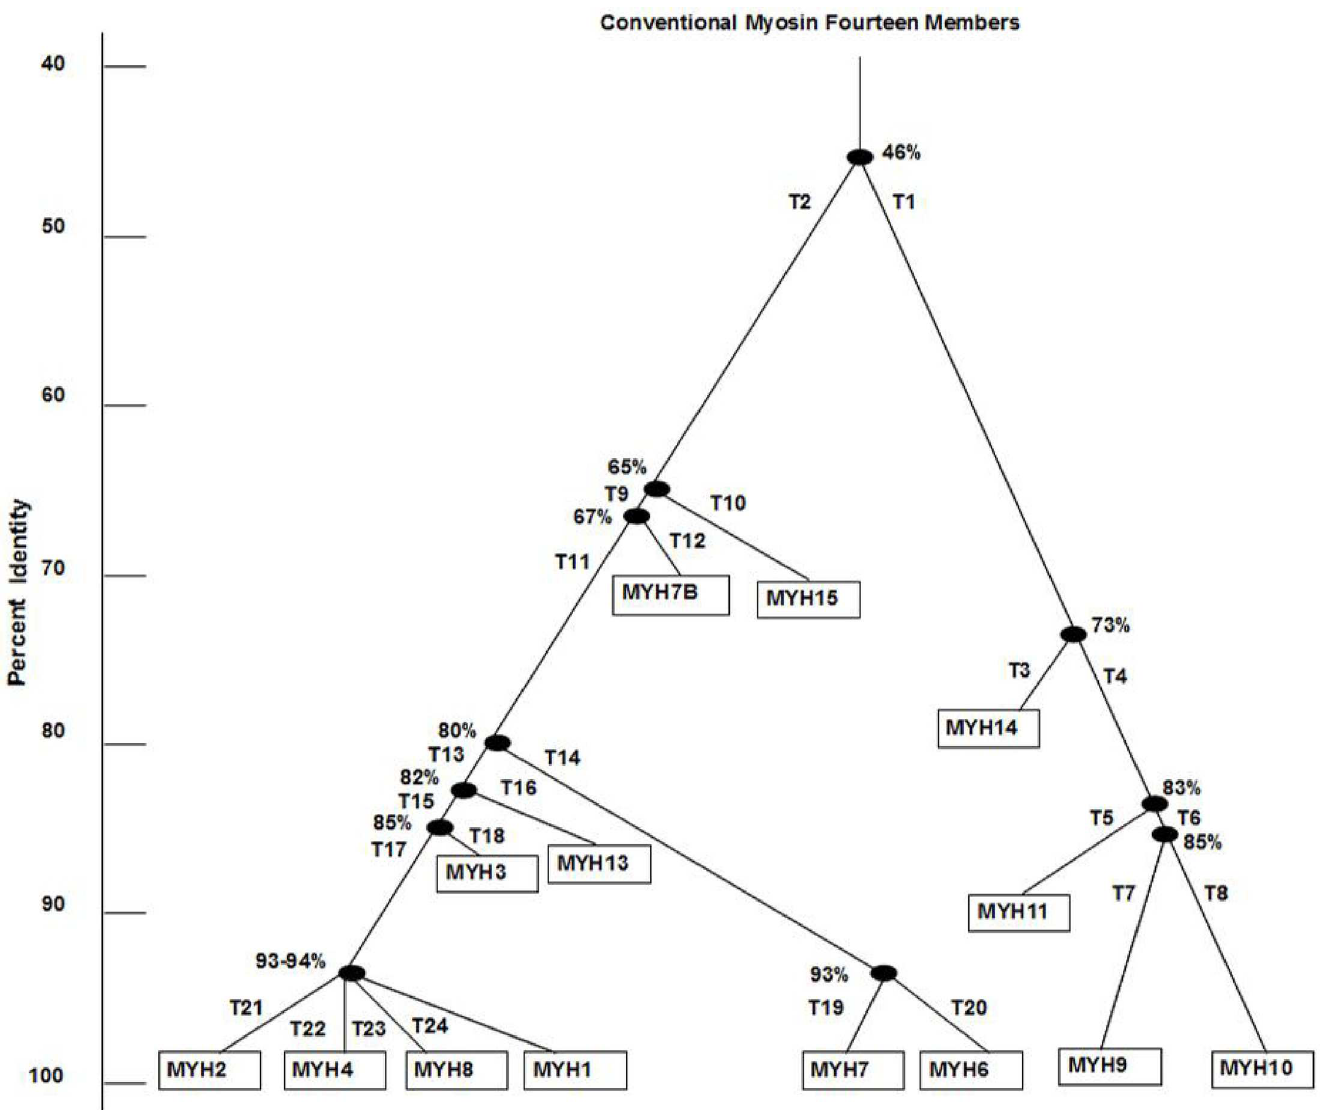
Fig 2. A rooted phylogenetic tree based on percent sequence similarity analysis of myosin heavy chain II head domain of